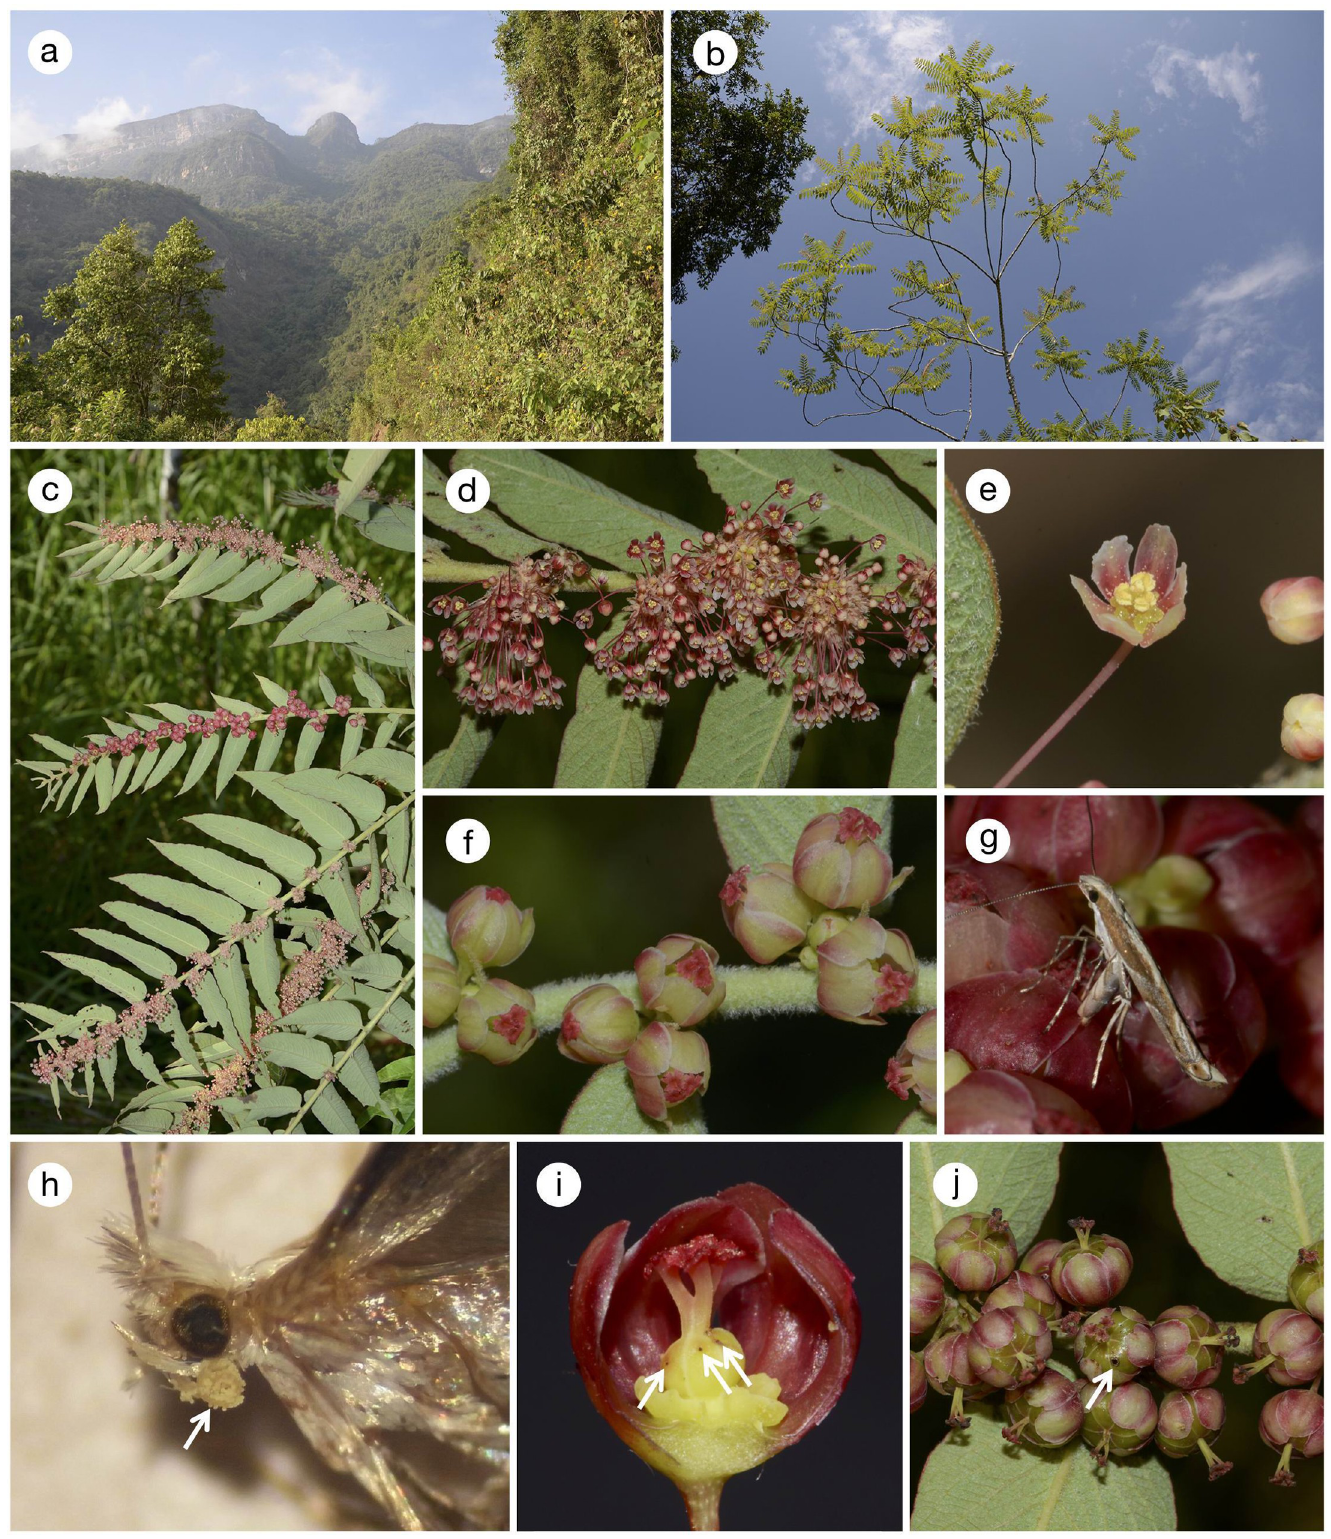
Fig 2. Phyllanthus salviifolius and associated Epicephala . (a) Habitat of P . salviifolius at La Florida; (b) habit; (c) branches bearing male and female flowers; (d) male flowers; (e) close-up of a male flower; (f) female flowers; (g) an E . anomala female ovipositing in ovary by penetrating the tepal with the ovipositor; (h) proboscis of